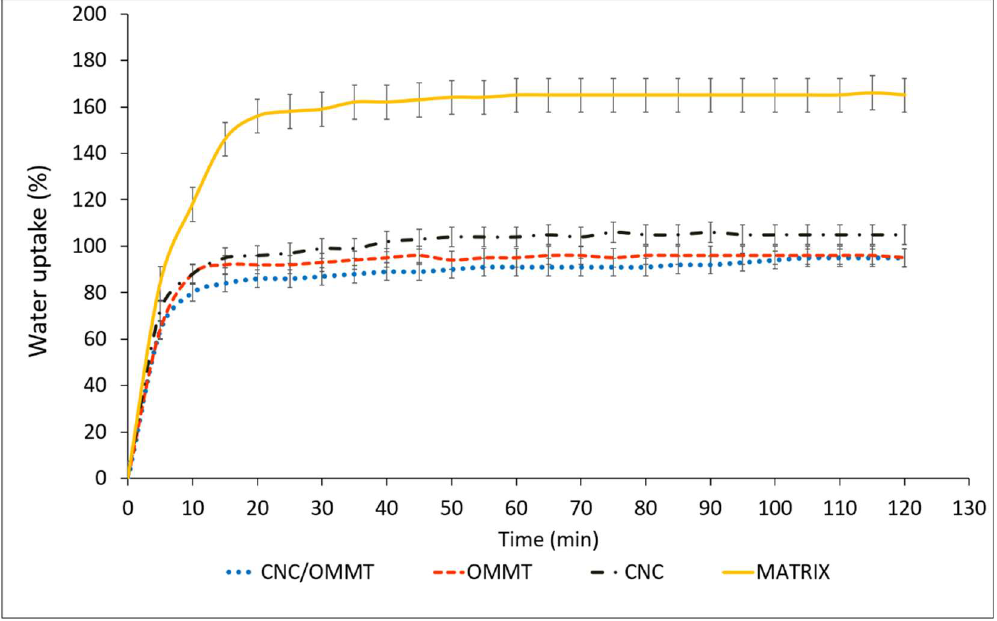
Figure 8. Water uptake of κ-carr matrix films: κ-carr matrix, κ-carr/CNC bionanocomposite, κ-carr/OMMT bionanocomposite, and hybrid κ-carr/CNC/OMMT bionanocomposite.